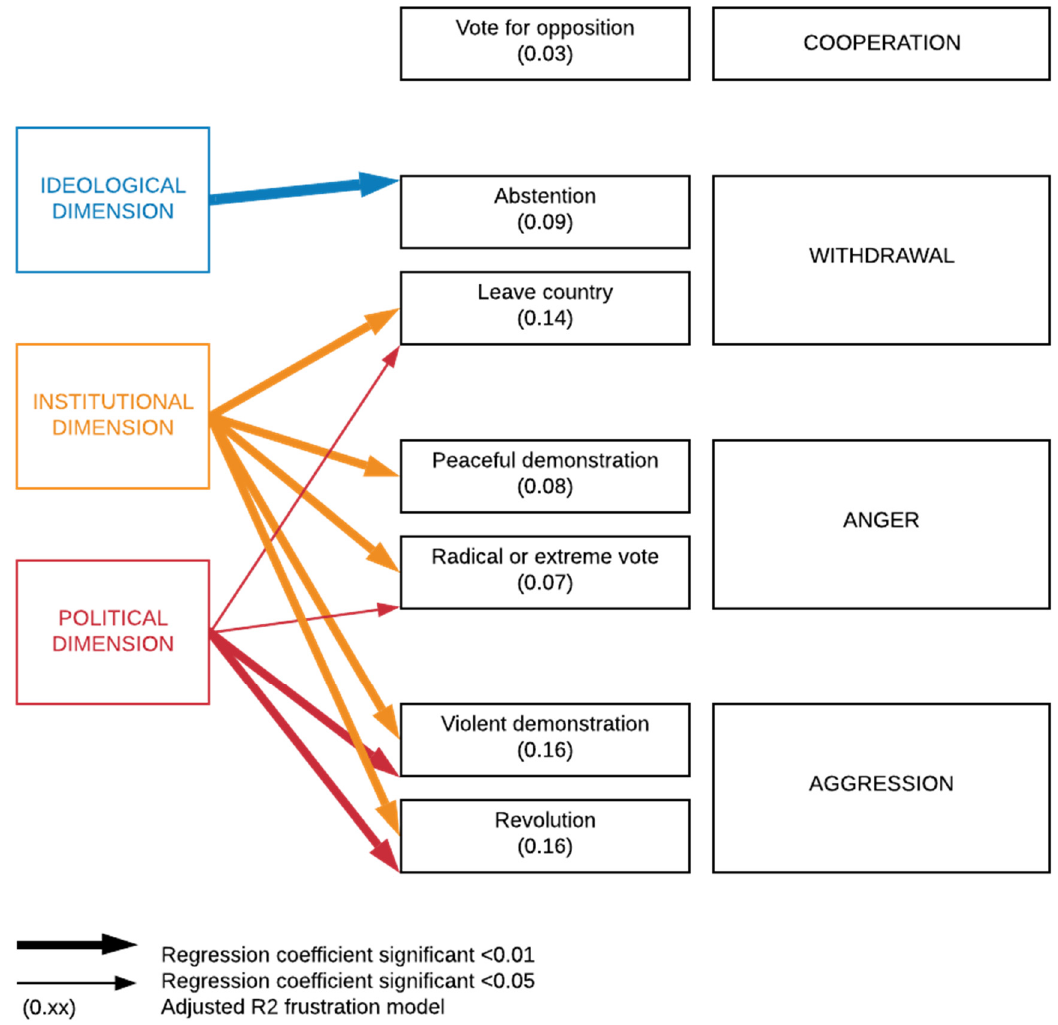
Figure 3. Pathologies of Democratic Frustration.